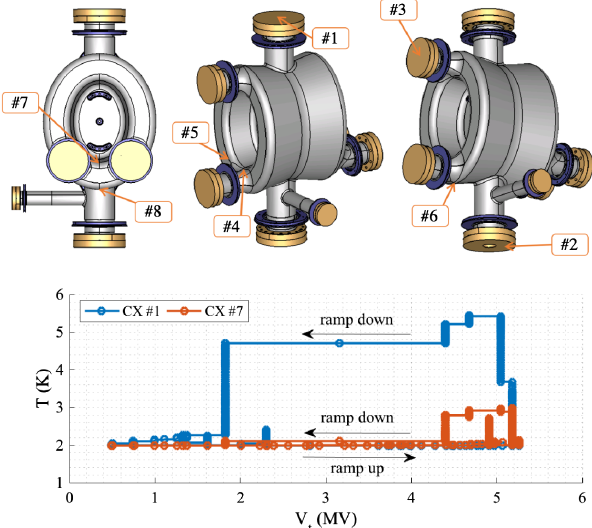
FIG. 13. Test of cavity 2 in September 2017: thermosensor location (above) and signal recorded from thermosensors (below).